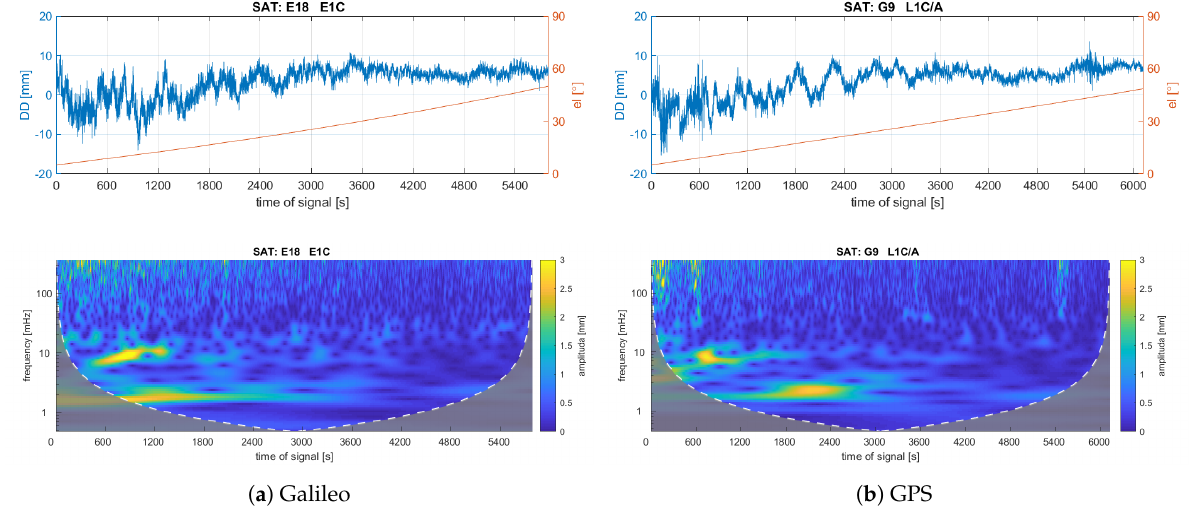
Figure 11. Double-difference phase residuals and scalograms for ( a ) Galileo E18 and ( b ) GPS G09